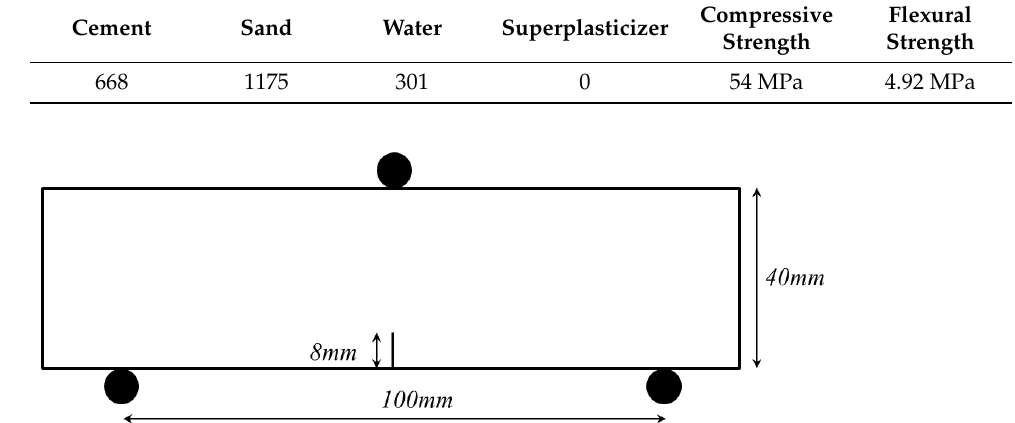
Table 5. Micro-parameters of the linear cohesive model obtained after calibration for small beam test.